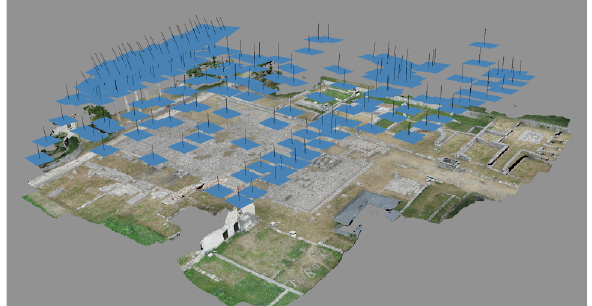
Figure 6. Photogrammetric model of Saepinum 's Forum .